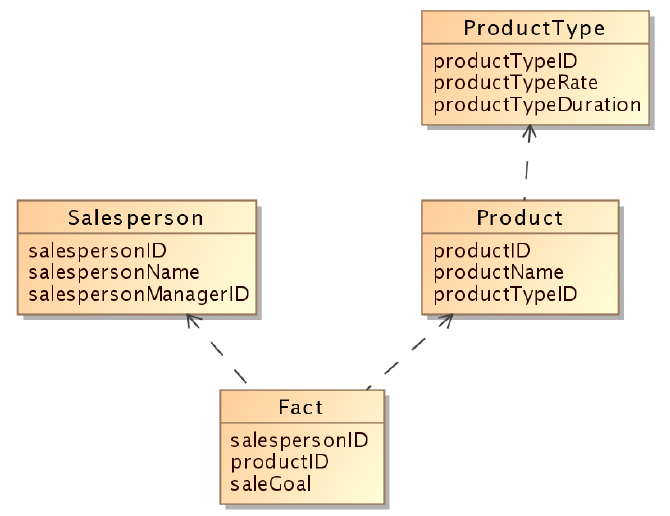
Figure 3. Sale multidimensional logical model.